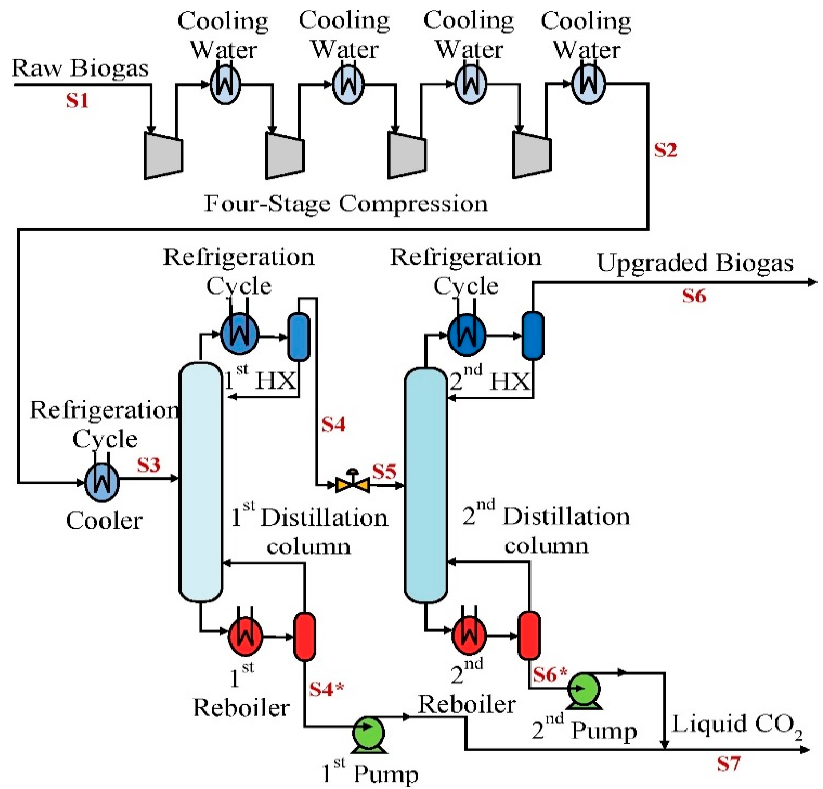
Figure 7. Cryogenic distillation plant scheme. The flows are listed as S followed by a number, the * has been used to highlight the two flows characterized by high CO 2 content (above 99%vol.). Reproduced with permission from [95]; published by Elsevier,